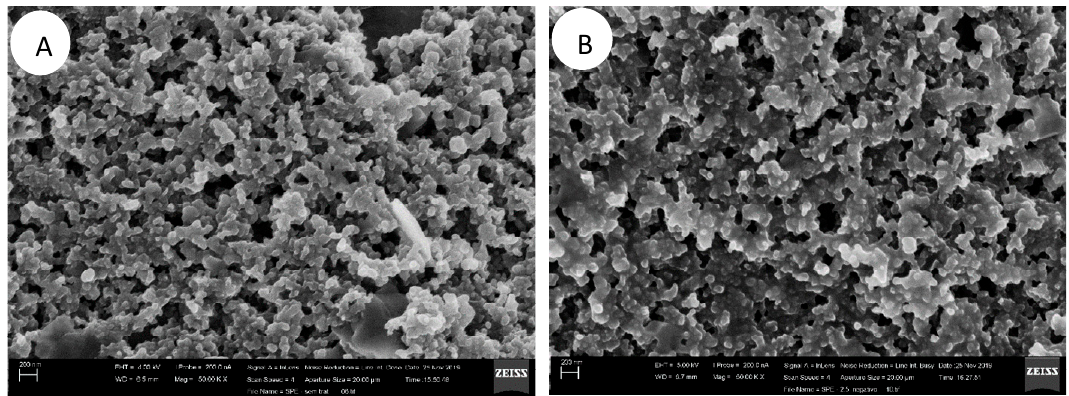
Figure 2. SEM-FEG images of flexible SPES before ( A ) and after ( B ) electrochemical pretreatment.